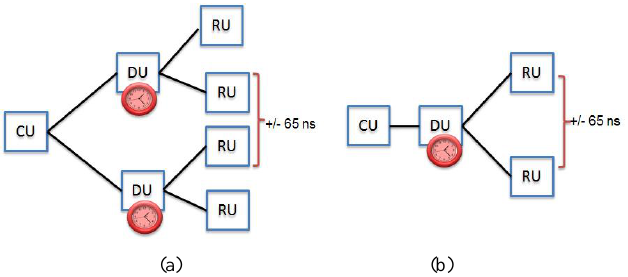
Figure 4. Illustration of relative time error alignment when RUs are connected to diferent DUs (a) and to the same DU (b) in the context of 5G use